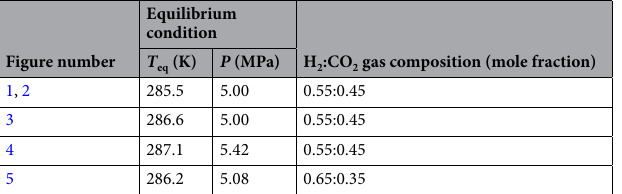
Equilibrium condition